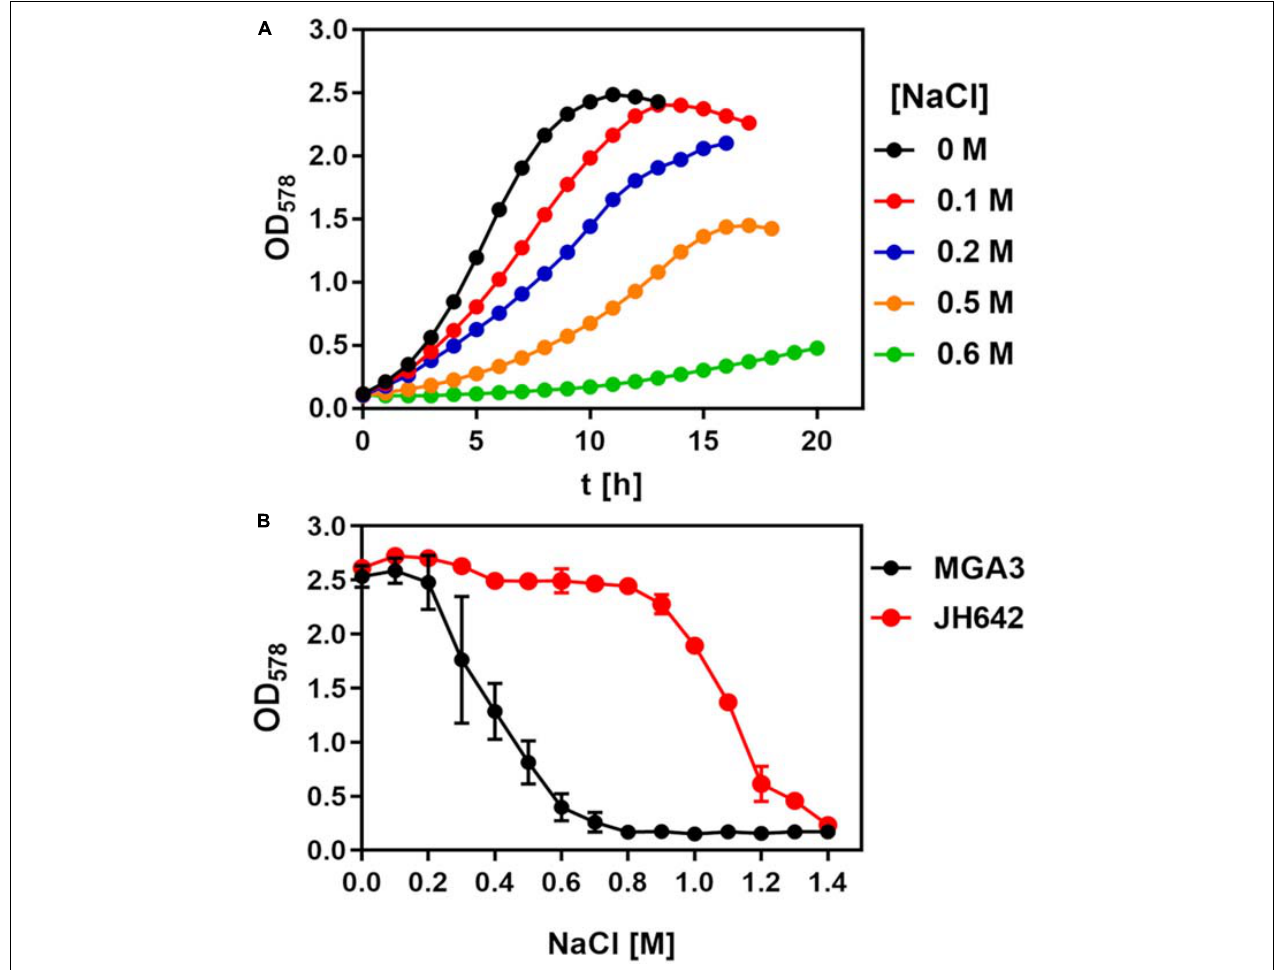
FIGURE 1 | Growth of Bacillus methanolicus MGA3 challenged by high salinity. (A) B. methanolicus MGA3 was grown in MVcM in shake-flasks (20 mL culture volume in 100 mL Erlenmeyer flasks) at 50 ◦ C in the presence of the indicated NaCl concentrations. Growth of the cultures was monitored by measuring their OD 578 values. The data shown represent a typical growth experiment. (B) Cultures of B. subtilis JH642 were grown in SMM at 37 ◦ C and B. methanolicus MGA3 was cultivated at 50 ◦ C in MVcM for 16 h, whereupon their growth yield was determined by measuring the OD 578 of the cultures. The data shown were derived from two biological